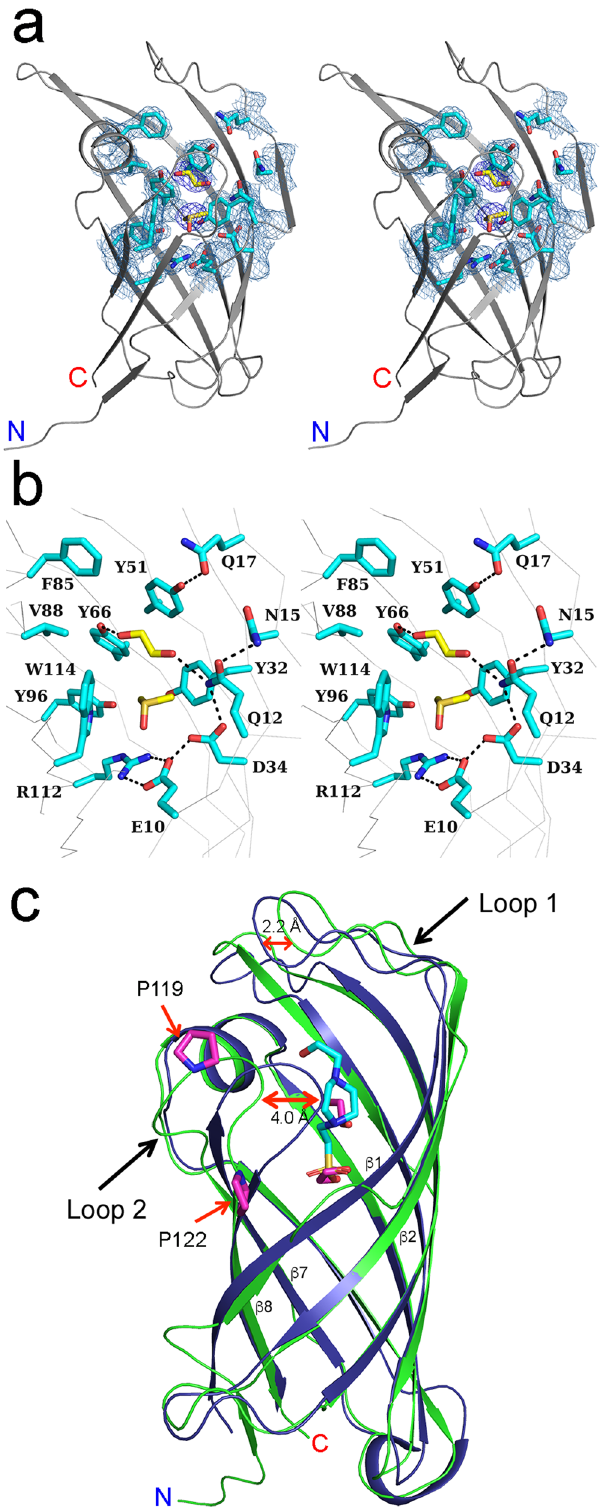
Fig. 4 Crystal structure of AbnU determined at 2.0 Å resolution. a Stereo view of the cartoon representation of the AbnU. Active site residues are shown as sticks in cyan covered with 2F o – F c electron density map ( σ = 1.3). An ethylene glycol (EDO) and DMSO molecules are shown as yellow sticks bound in the β -barrel region. b Stereo view of AbnU active site depicting the active site residues interacting with EDO and DMSO molecules. Tryptophan (W114) occupies major part of the β -barrel cavity, while E10 and R112 pair-up to form a salt bridge. c Cartoon representation of the superposition of AbnU (green) and its homologue AbyU (blue) (PDB: 5DYV). The major difference between the two structures is at the loop region between β 1- β 2 (Loop 1) and between β 7- β 8 (Loop 2). The later loop in the AbnU contains two proline (P119 and P122) residues that might restrict the free movement of Loop